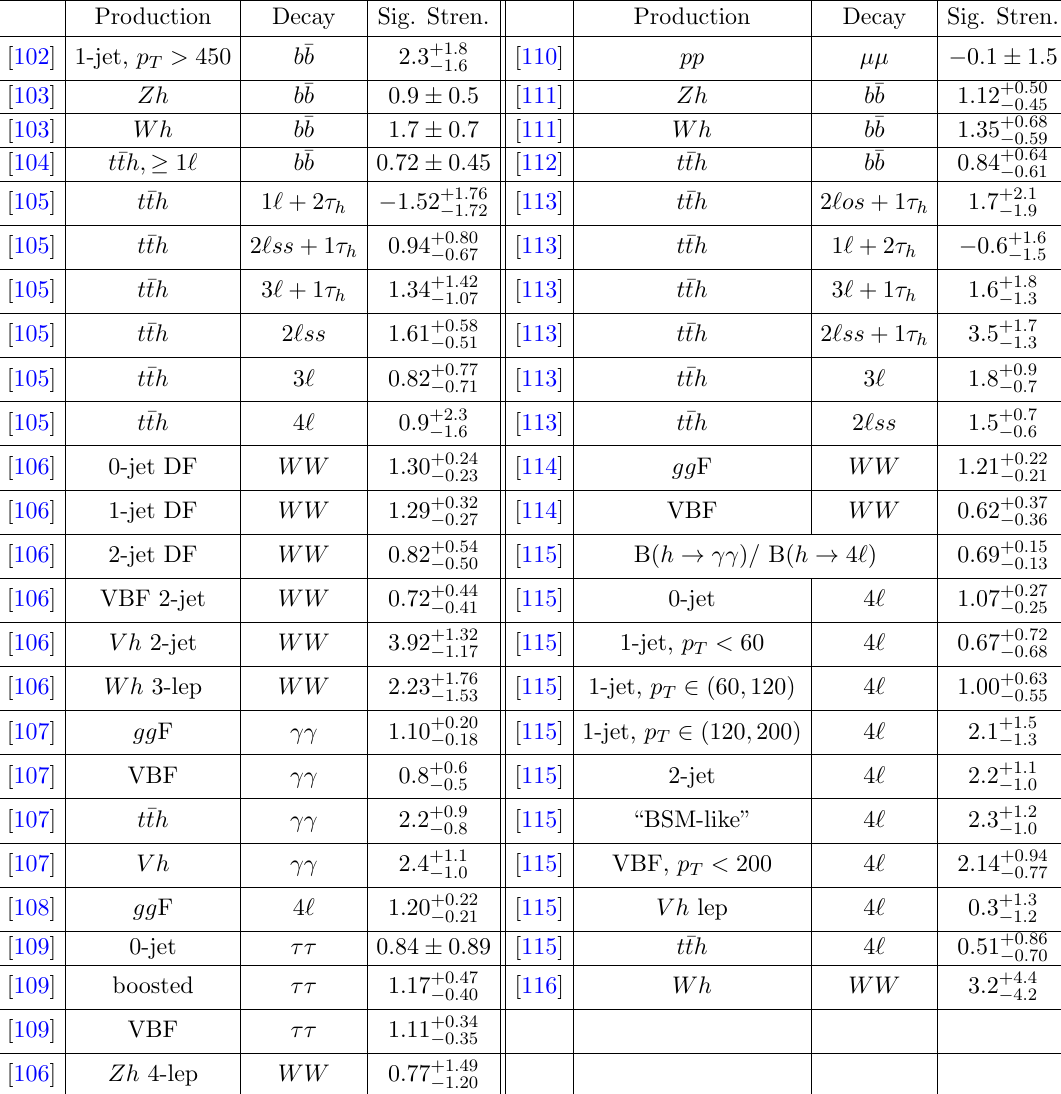
Table 3. Summary of LHC Run 2 Higgs results used in this work. The left side of the table lists results from CMS, and the right side lists results from